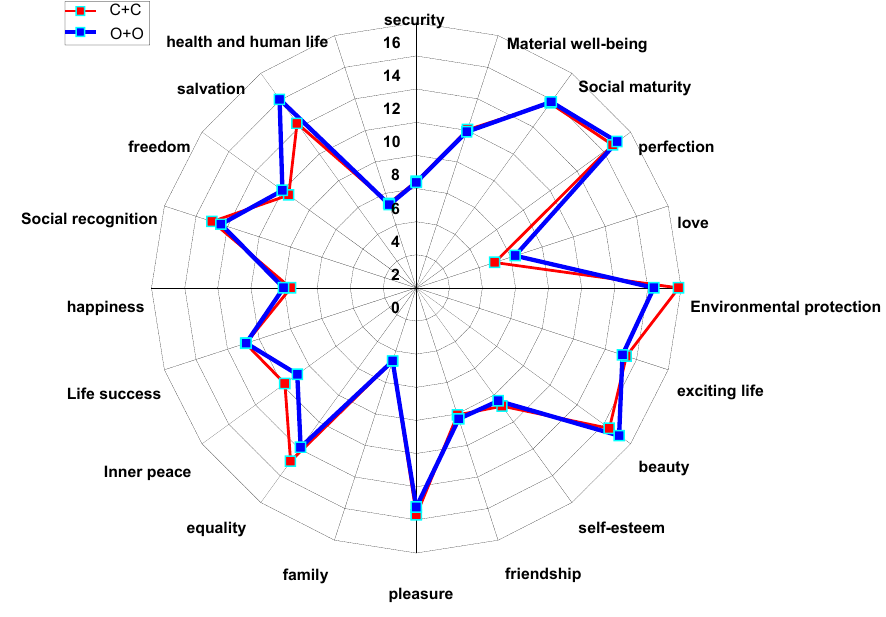
Figure 1. A list of preferences of the final values of Catholic and Orthodox respondents representing the same denomination as their family. Source: own study based on research results.